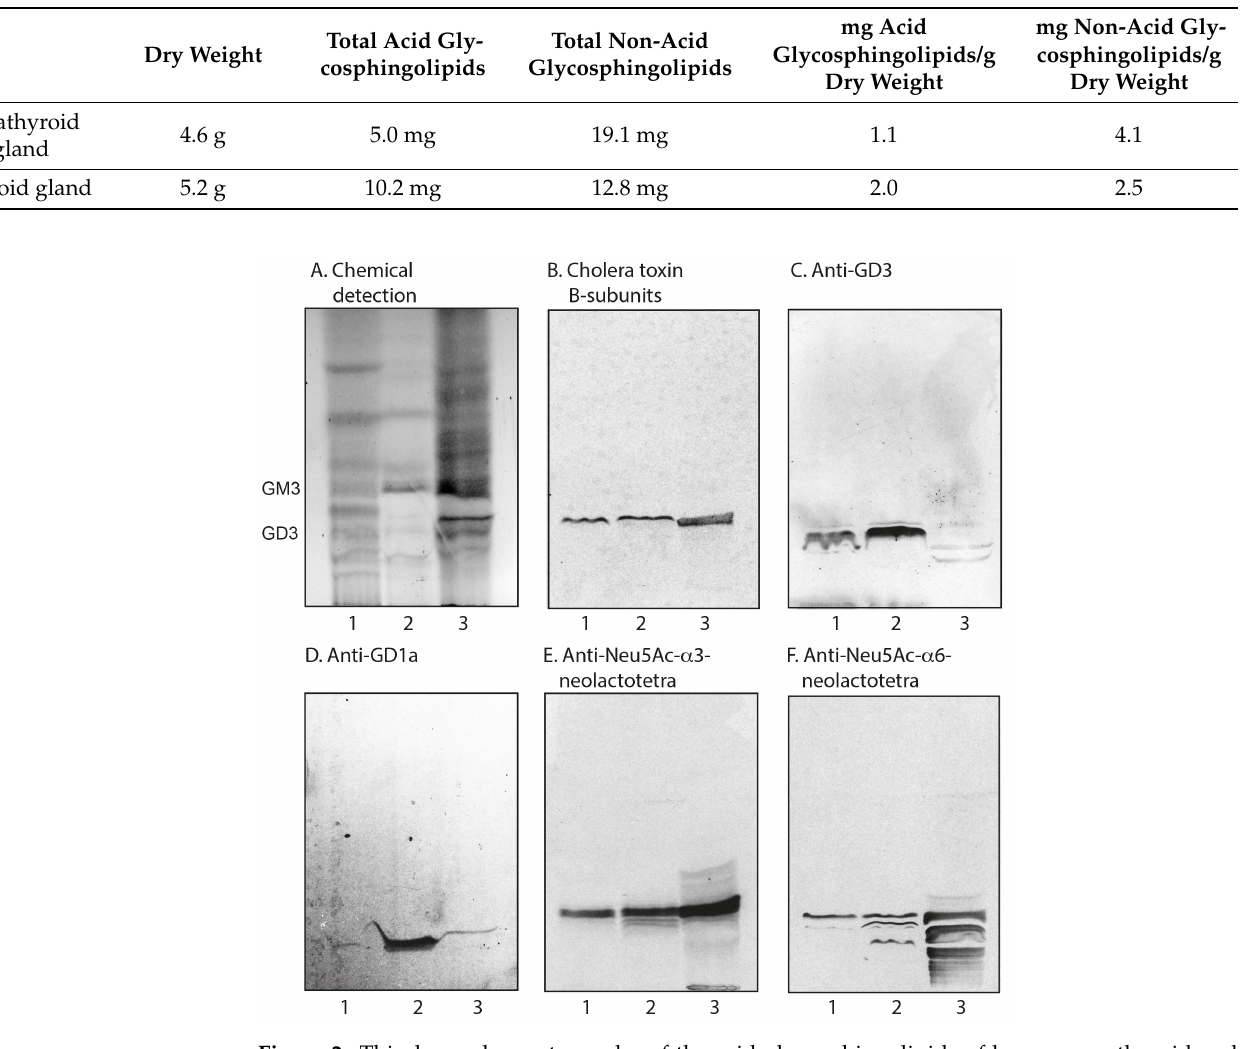
Figure 2. Thin-layer chromatography of the acid glycosphingolipids of human parathyroid and thyroid glands, and binding of carbohydrate-recognizing ligands. Thin-layer chromatogram after de- tection with anisaldehyde ( A ), autoradiograms obtained by binding of ganglioside GM1-recognizing cholera toxin B-subunits ( B ), monoclonal antibodies directed against the ganglioside GD3 ( C ), the ganglioside GD1a ( D ), the Neu5Ac α 3Gal β 4GlcNAc sequence ( E ), and the Neu5Ac α 6Gal β 4GlcNAc sequence ( F ). The lanes were: lane 1, total acid glycosphingolipids of human parathyroid glands, 80 µ g; lane 2, total acid glycosphingolipids of human thyroid glands, 80 µ g; lane 3, reference